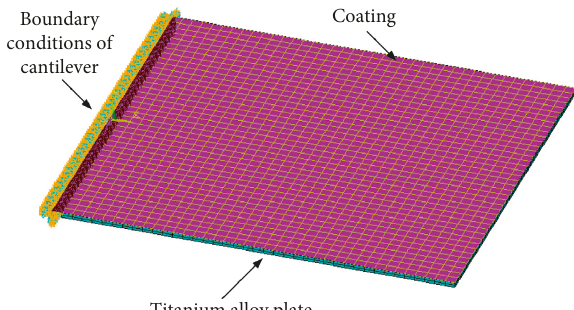
Figure 13: Finite element model of cantilever coating-plate composite